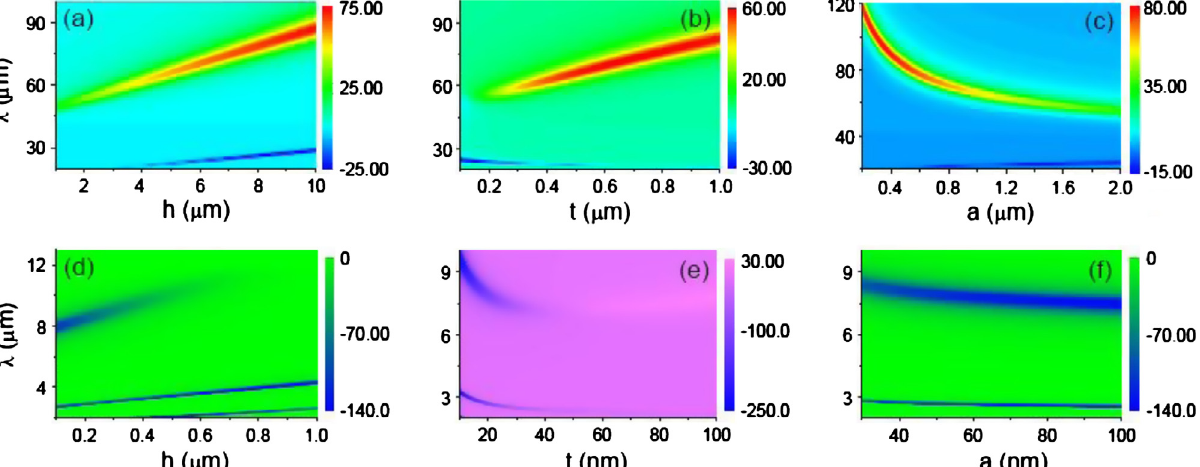
Figure 10. Enhanced electromagnetic pressure as a function of wavelength and structure sizes for the THz (a–c) and infrared (d–f) regime. The structure parameters are the same as those set in Figure